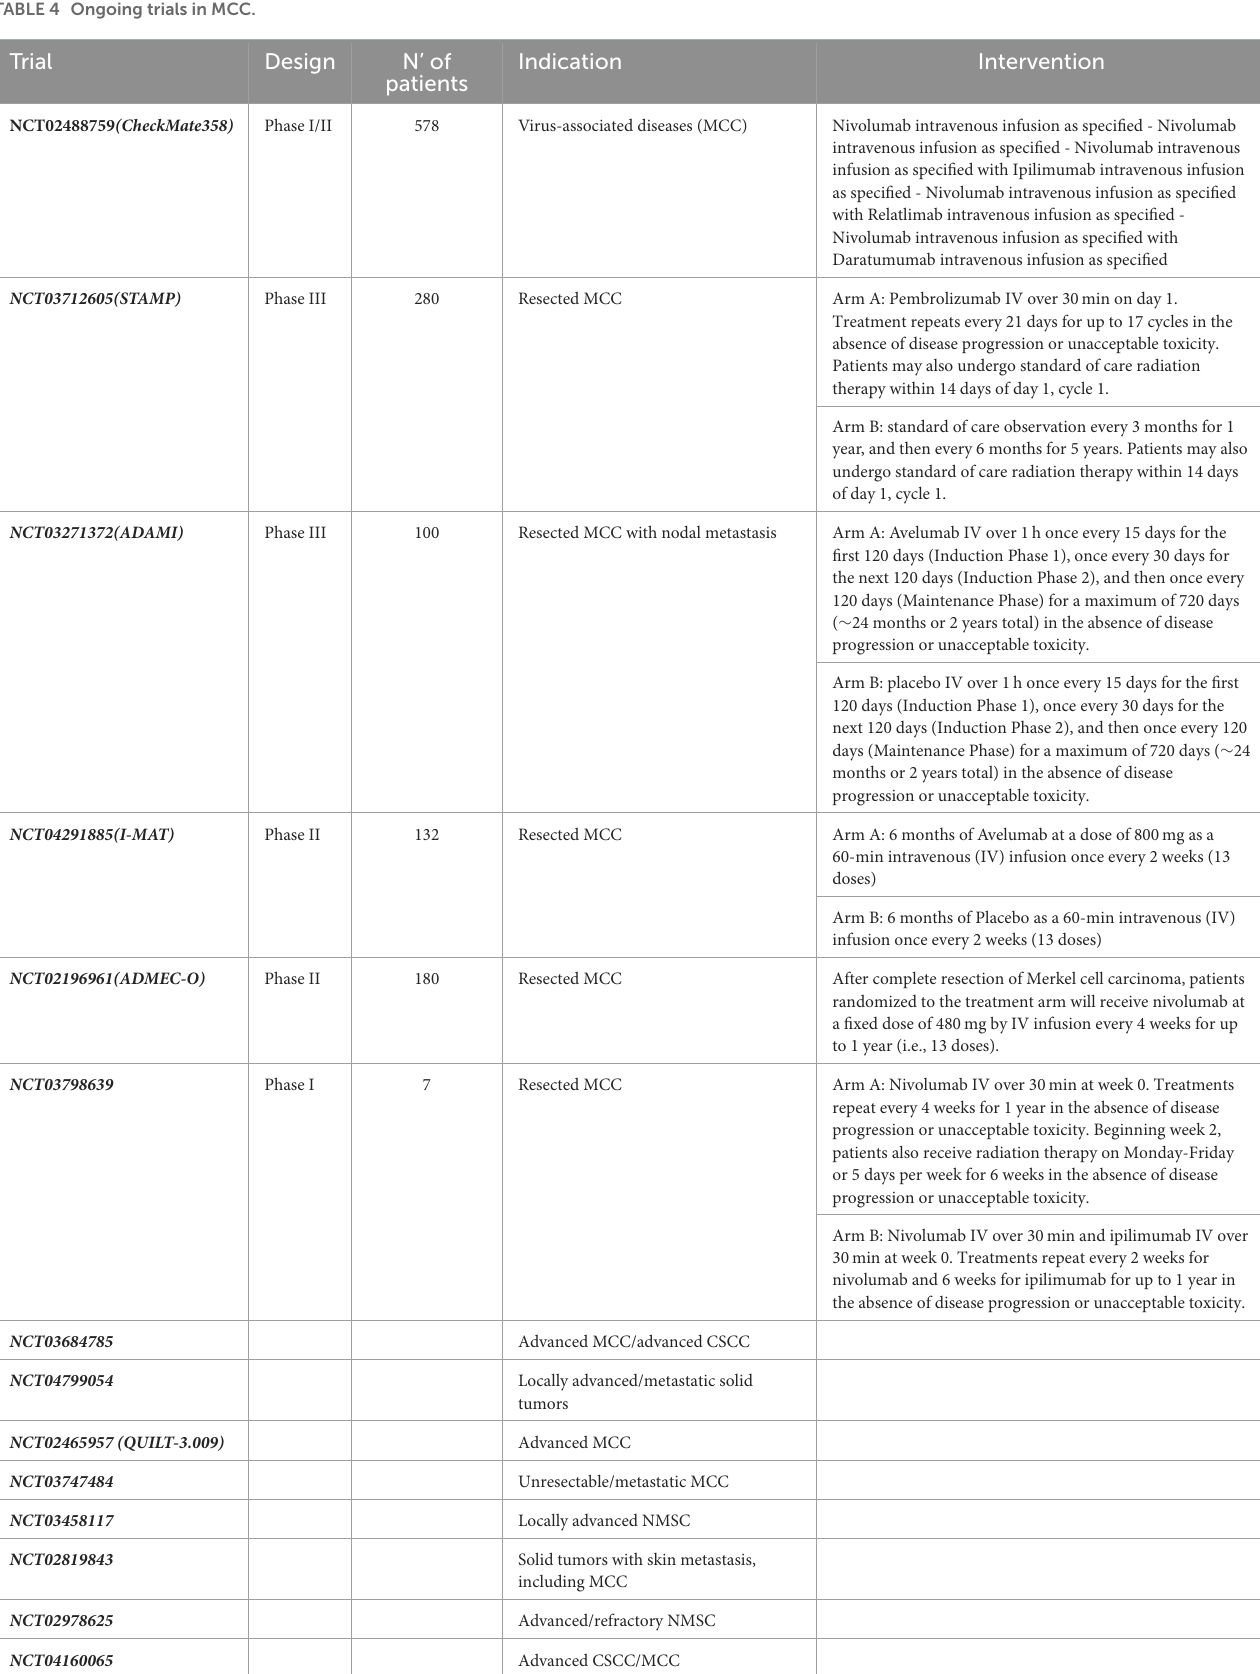
TABLE 4 Ongoing trials in MCC.